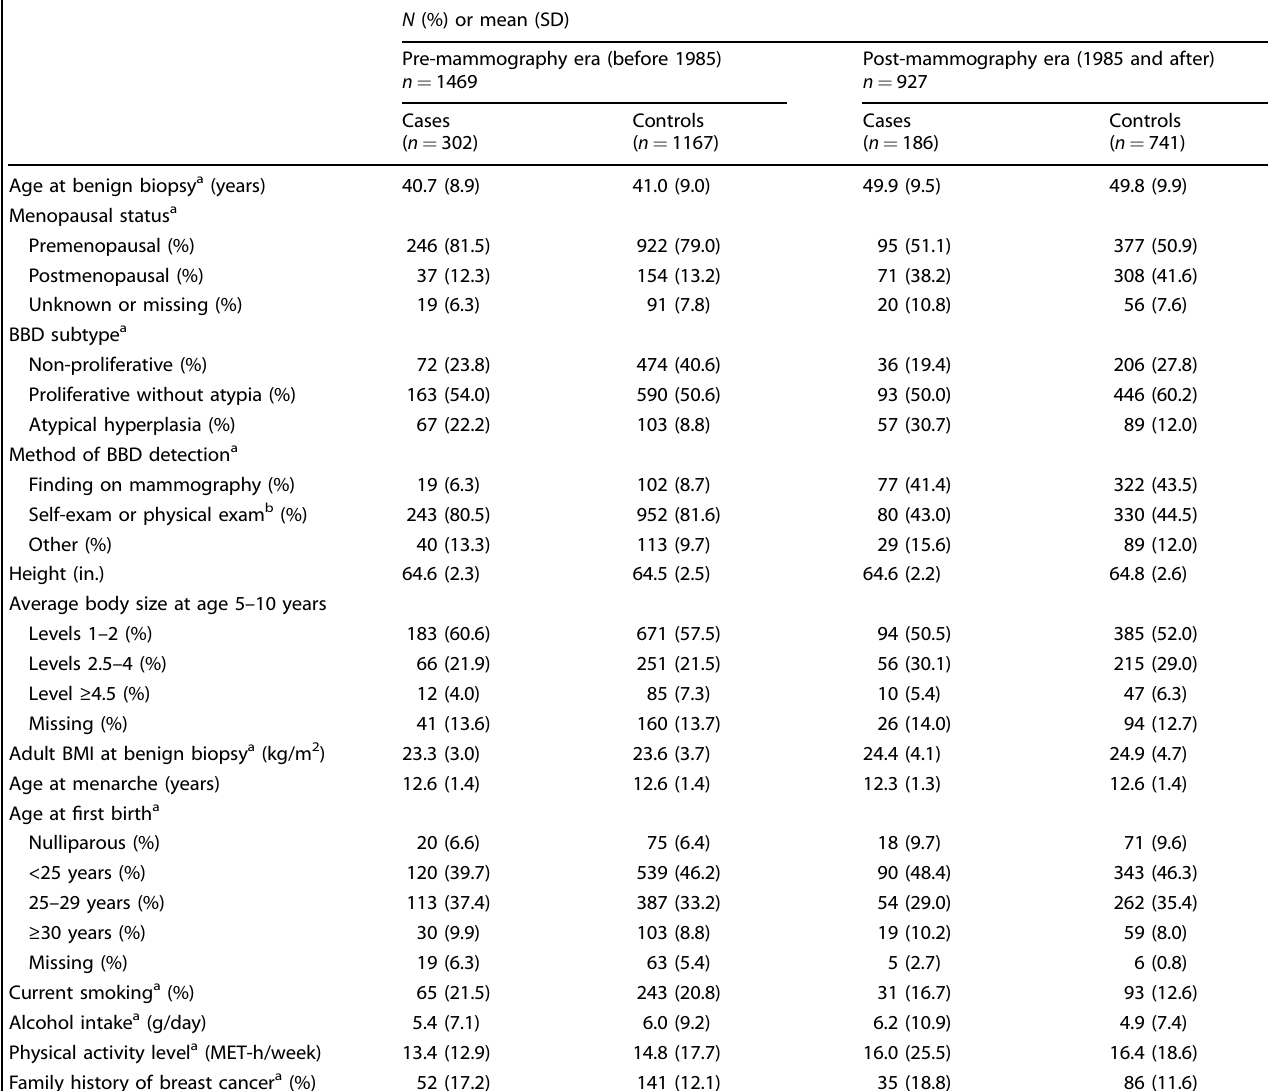
Table 1. Participant characteristics according to case – control status and pre- (before 1985) vs. post-mammography era (1985 and after) of BBD diagnosis.